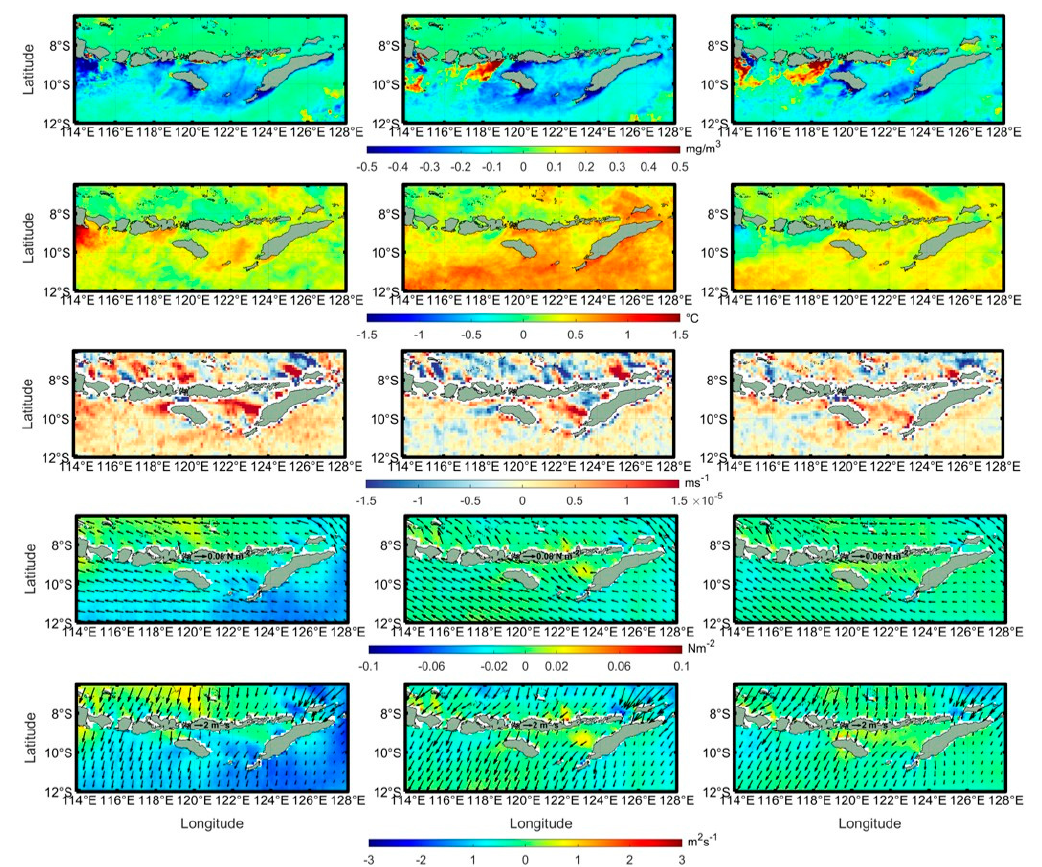
Figure 13. The anomalies of chlorophyll-a, sea surface temperature (SST), Ekman Pumping Velocity (EPV), wind stress, and Ekman Mass Transport (EMT) during the 2009 El Nino (June–August from left to right), respectively (from top to bottom).